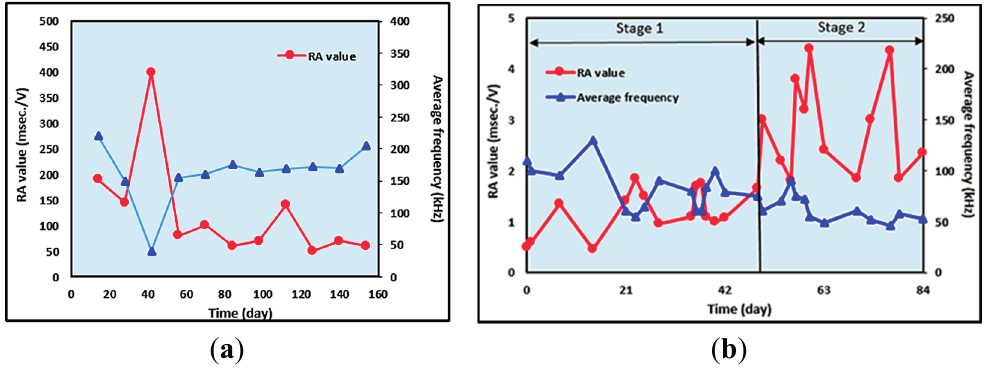
Figure 8. Variations in RA values and average frequency ( a ) Ohtsu and Tomoda ( Reproduced and modified from [156]) and ( b ) (Reproduced and modified from Kawasaki et al .